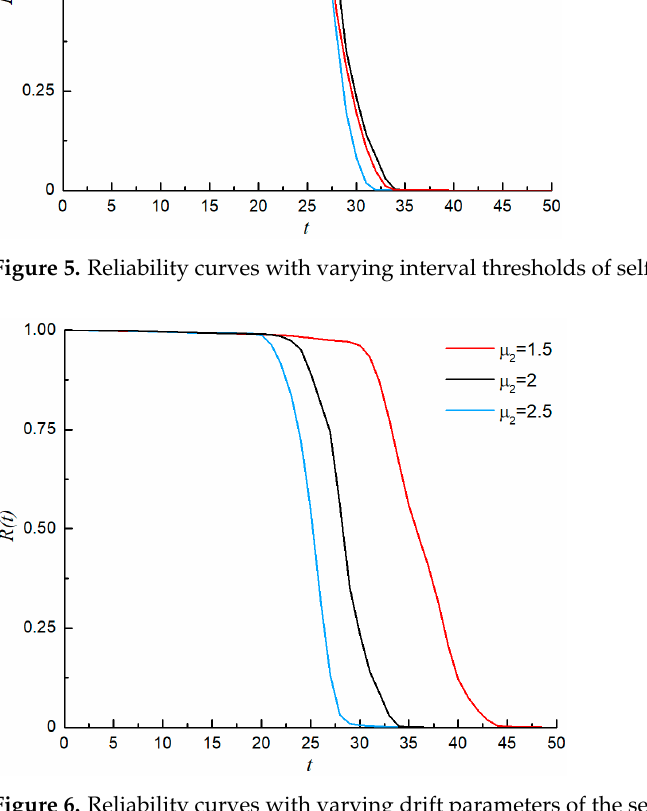
Figure 6. Reliability curves with varying drift parameters of the second Wiener process.